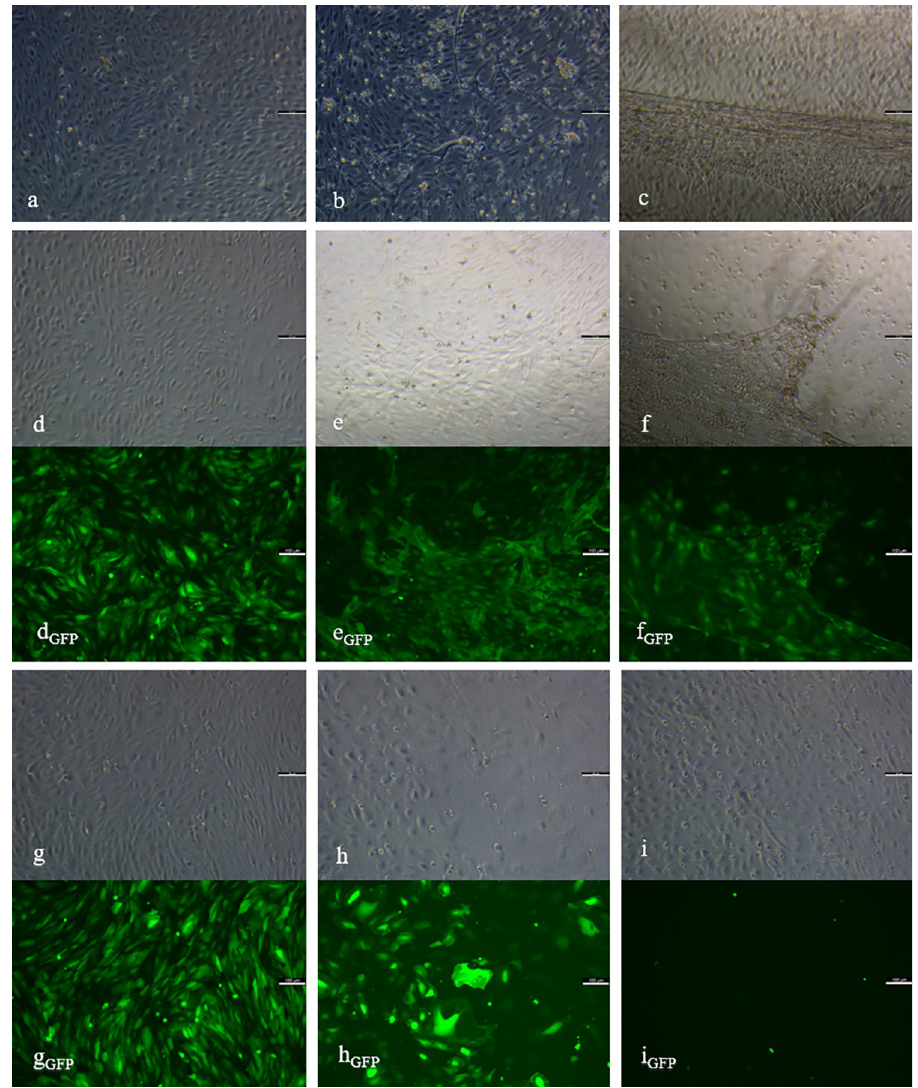
Fig 2. Angiogenesis in vitro of ECs of HD1. Native (a-c), control (d-f) and knockdown group (g-i) including the eGFP control of SCR 1 (d GFP , e GFP , f GFP ) and sh 1 (g GFP , h GFP , i GFP ) at day 5 (a, d, d GFP , g, g GFP ), 25 (b, e, e GFP , h, h GFP ) and 50 (c, f, f GFP , i, i GFP ) of cultivation are presented. Elongated and linearly arranged cells of stage 2–3 (a, d, g) in all groups at day 5, was followed in N 1 and SCR 1 by networking (b, e) and three-dimensional organisation of stage 5–6 (c, f). The knockdown group showed a decrease (h), followed by an increase in cell density, ending up with networking structures of stage 4 (i). Control group showed positive eGFP control during the investigation period (d GFP , e GFP , f GFP ), whereas sh 1 displayed a reduction in fluorescent signals (g GFP , h GFP , i GFP ). Scale bars = 100 μ